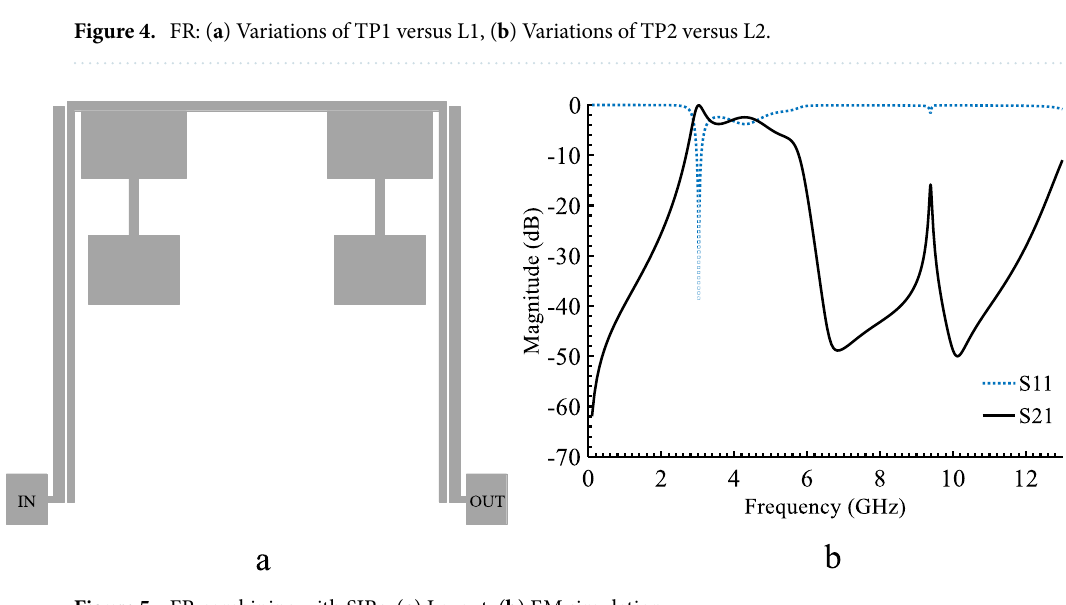
Figure 5. FR combining with SIRs: ( a ) Layout, ( b ) EM